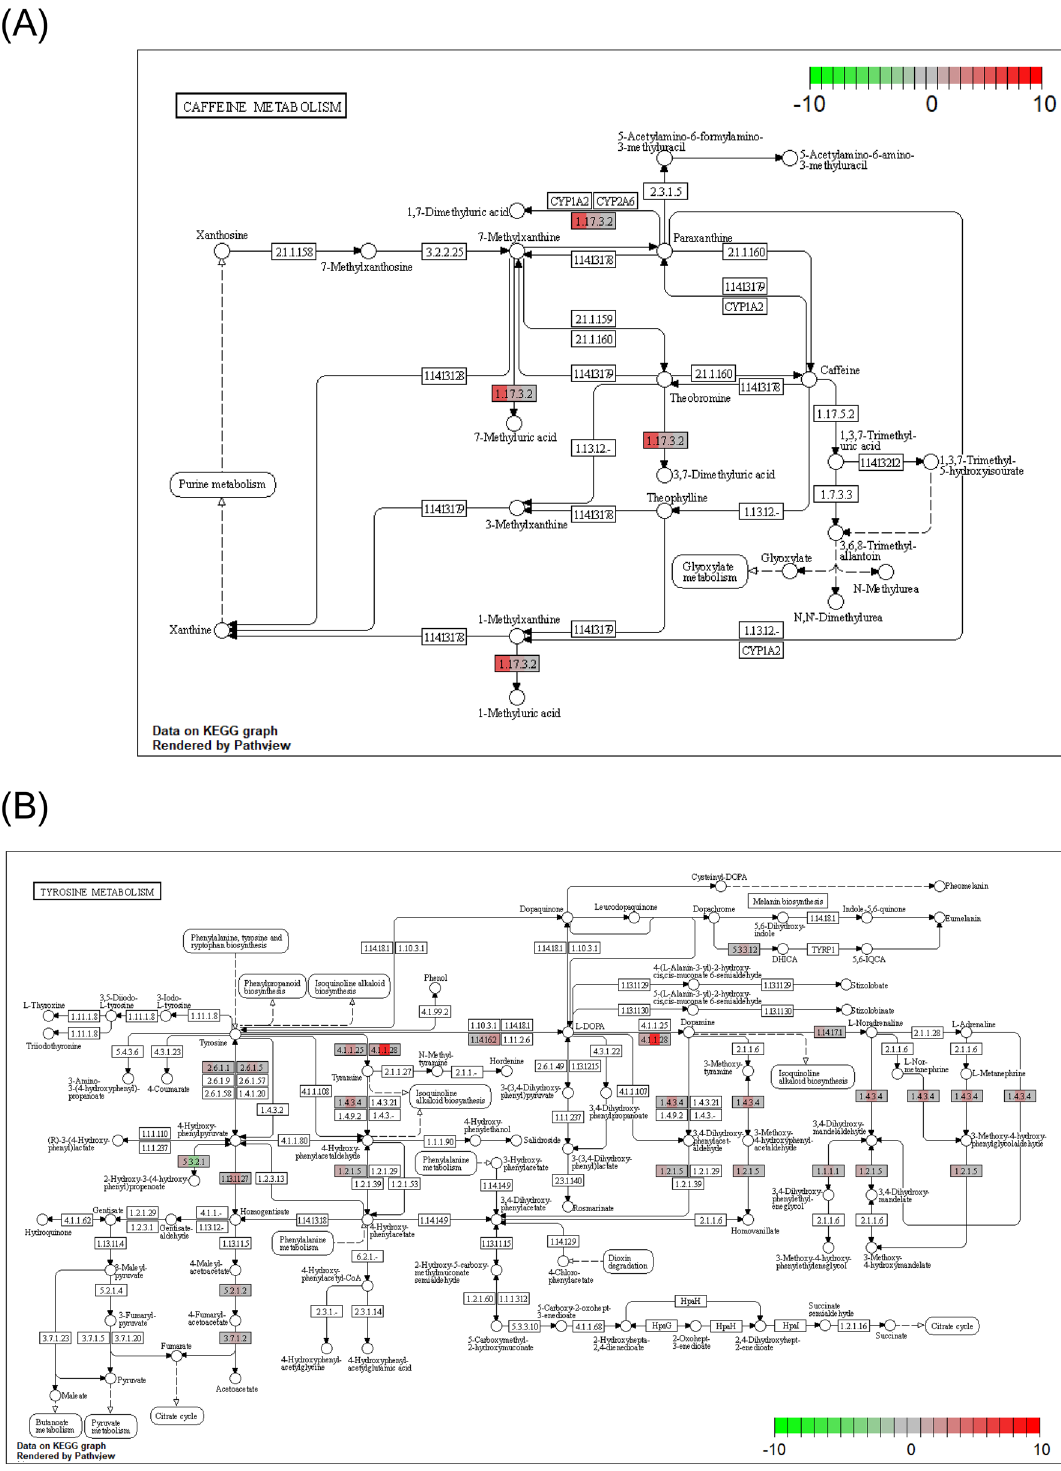
Figure 7. Functional genes with frequency of nonsynonymous variants in KEGG pathways. Each pathway map is generated using the R package “Pathview” (version 1.30.1, https:// bioco nduct or. org/ packa ges/ relea se/ bioc/ html/ pathv iew. html). Caffeine metabolism ( A ), tyrosine metabolism ( B ), tryptophan metabolism ( C ), metabolism of xenobiotics by cytochrome P450 ( D ), longevity regulating pathway ( E ) and circadian rhythm ( F ) are indicated. Reference nucleotide (Tcas5.2) obtained from the NCBI genome database. The color gradient in the rectangular box represents nonsynonymous variant burden or differences in the intensity of fold change by RNA-seq between the long and short strains (left, long variant burden; center, fold change; right, short variant burden). The upper fold change means the expression value of the long strain is higher than that of the short strain. The lower fold change means the